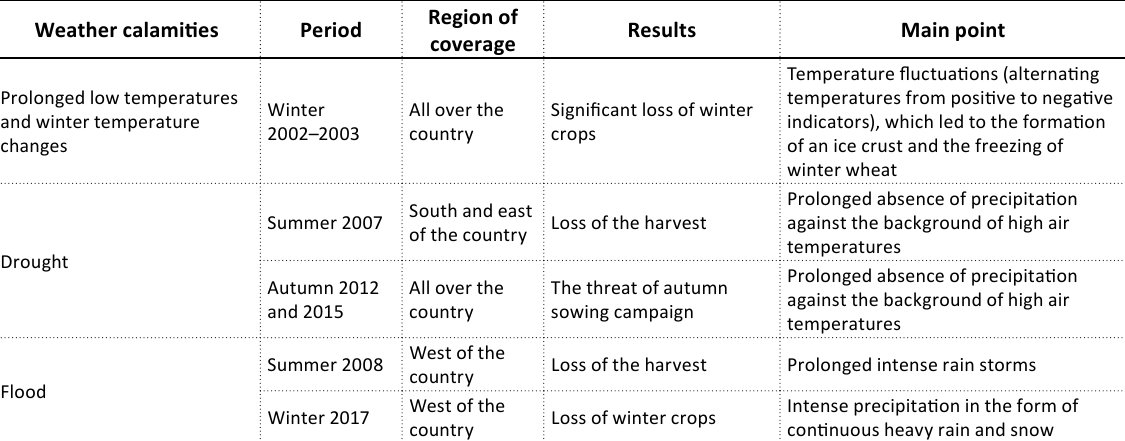
Table 1. Historical retrospective of large-scale weather-related calamities faced by Ukrainian agricultural producers